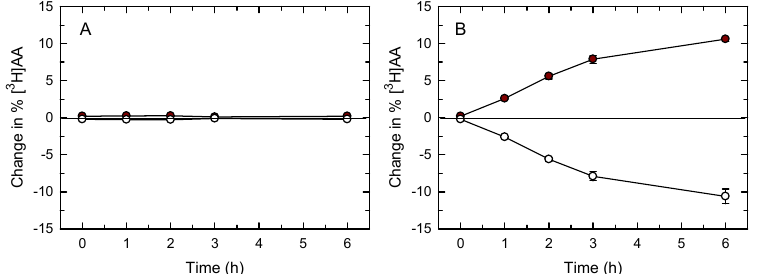
Figure 4. Transfer of [ 3 H]AA from TAG to phospholipids. Cells prelabeled with [ 3 H]AA were either untreated ( A ) or stimulated with 0.5 mg/mL zymosan for 2 h ( B ). Afterward, they were washed and transferred to fresh media, and the distribution of [ 3 H]AA content in phospholipids (maroon symbols) and TAG (open symbols) was determined at the times indicated. The data are expressed as mean values ± S.E.M. ( n = 6).